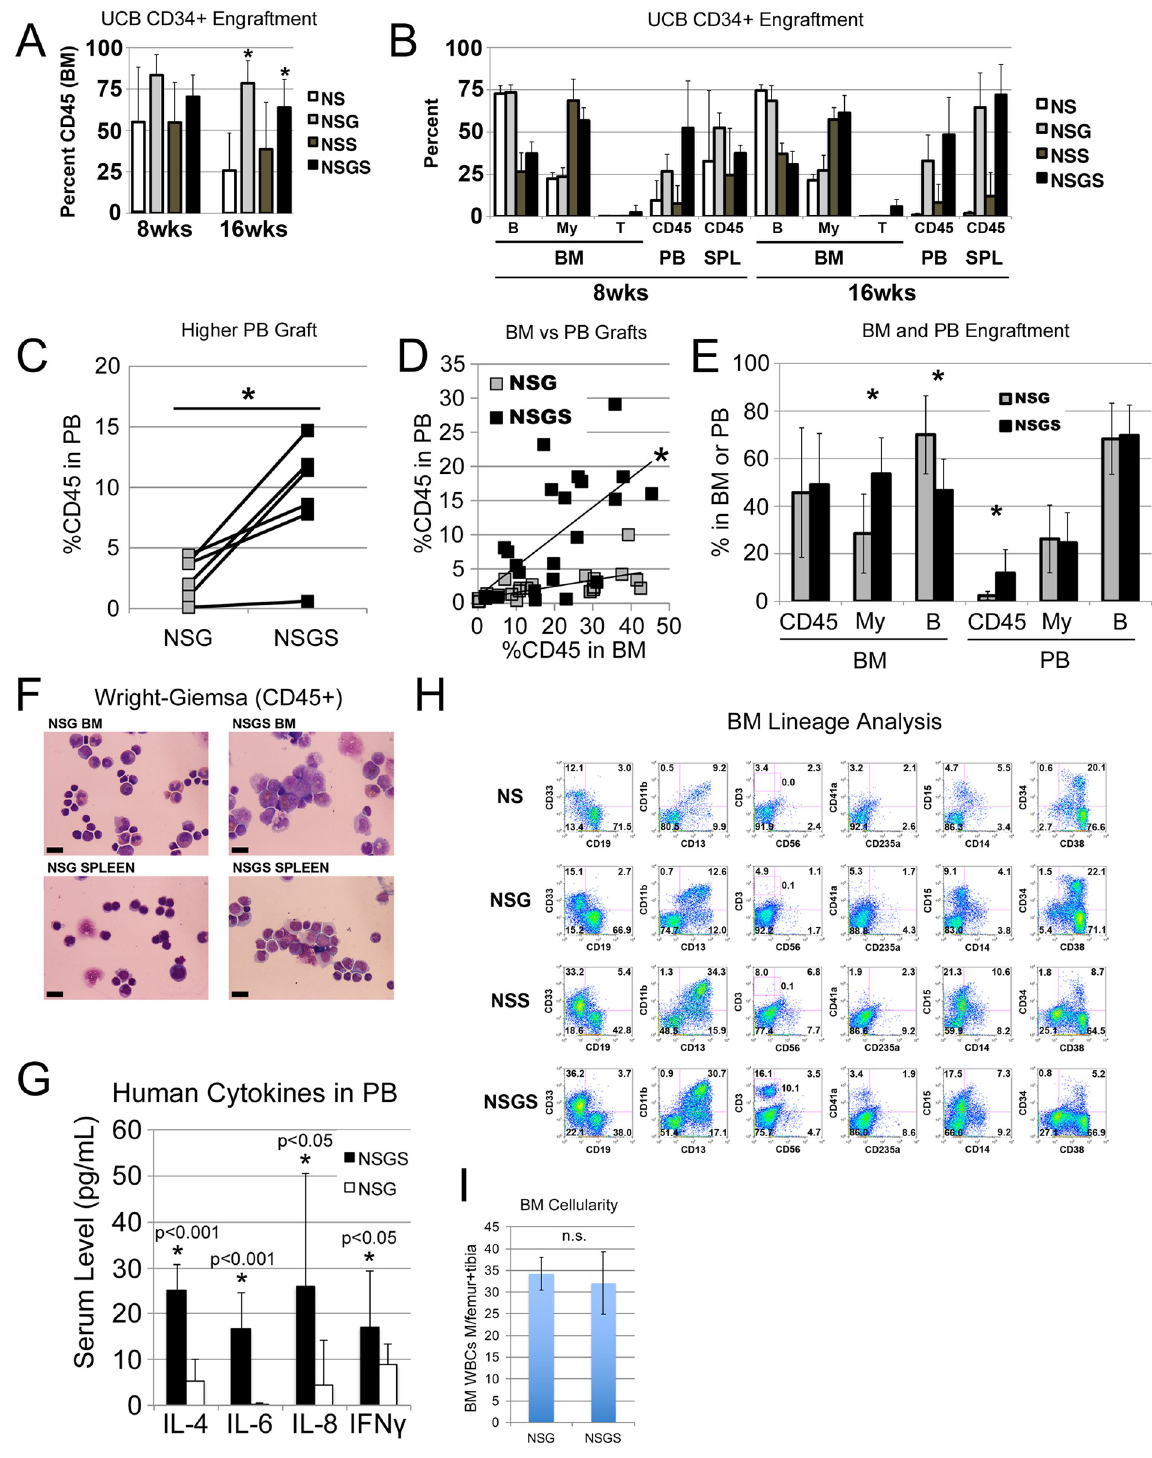
Fig 1. Four strain comparison of engraftment. A) Total human engraftment (CD45+) in the BM of mice at 8 and 16 weeks. B) Lineage composition of the human grafts from the BM, PB and spleen. B cells (CD19+), myeloid cells (CD13+ and CD33+), and T cells (CD3+) were assessed within the CD45+ population. C) PB CD45+ levels in mice engrafted with 6 unique UCB CD34+ preparations 6–8 weeks after engraftment. D) PB grafts from mice in “C” were plotted against the BM grafts from the same mice. The slopes of the trendlines were judged to be different by linear regression analysis, Prism 7 software, p = 0.0023. E) Lineage analysis of BM and PB for the grafts in “C”. F) Wright Giemsa